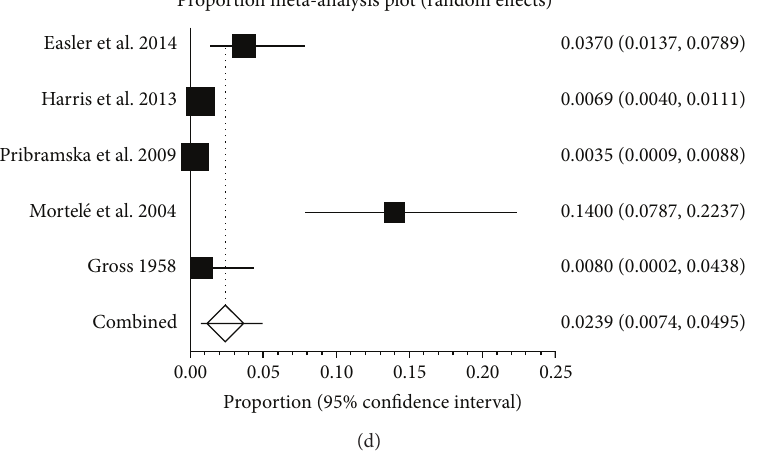
Figure 9: (a) Forest plots showing the prevalence of splanchnic vein thrombosis (SVT) in America. (b) Forest plots showing the prevalence of portal vein thrombosis (PVT) in America. (c) Forest plots showing the prevalence of splenic vein thrombosis (SlpVT) in America. (d) Forest plots showing the prevalence of mesenteric vein thrombosis (MVT) in